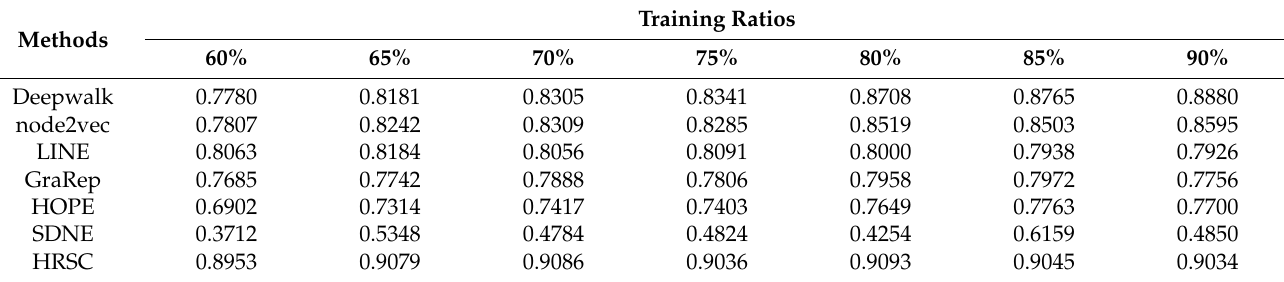
Table 8. AUC values on wordnet.